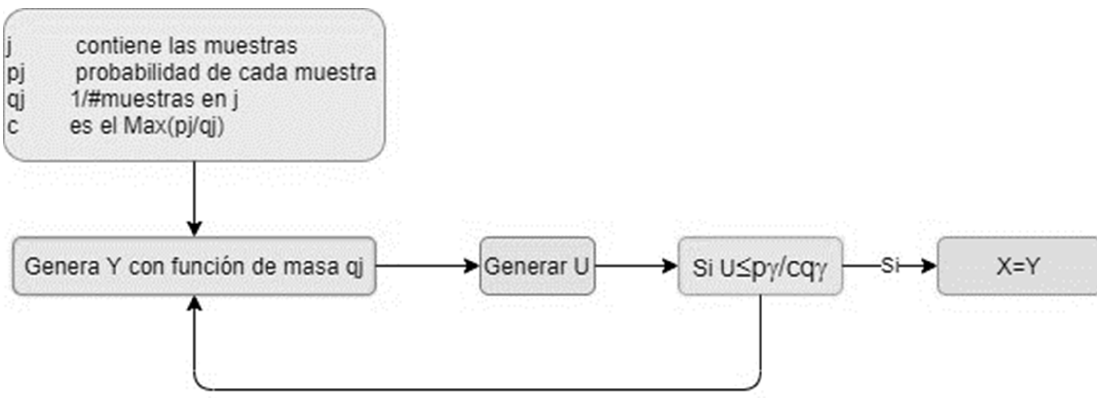
Figure 4. Acceptance–Rejection technique diagram.